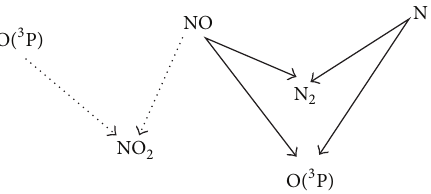
Figure 9: Diagram of main reaction paths for NO removal after discharge, including NO substituted by N as major reaction path (solid line) and NO oxidized by O( 3 P) as minor reaction path (dotted